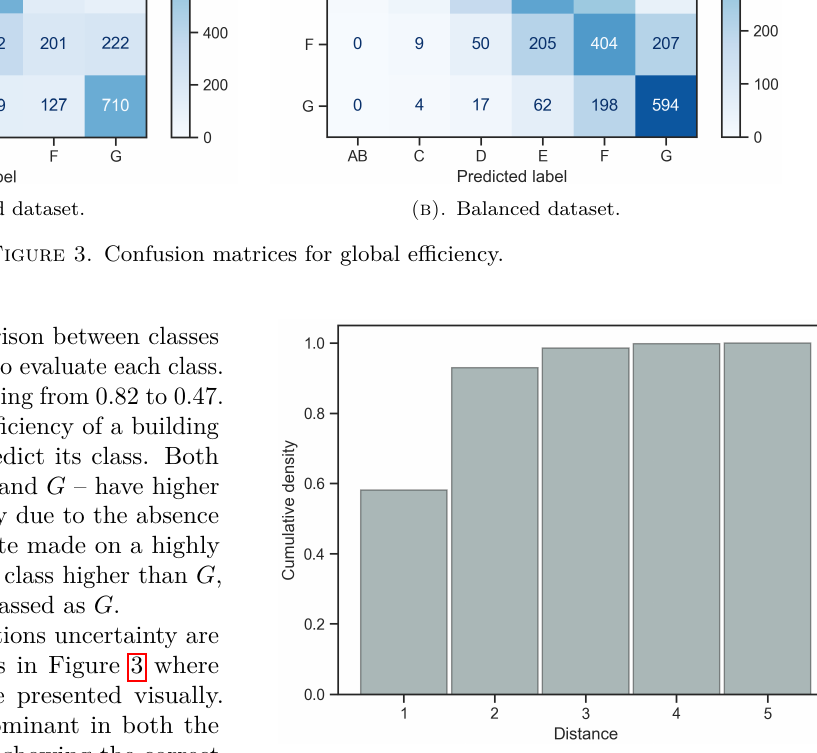
Figure 4. Cumulative distribution of the distances between true and predicted global efficiency given two two different